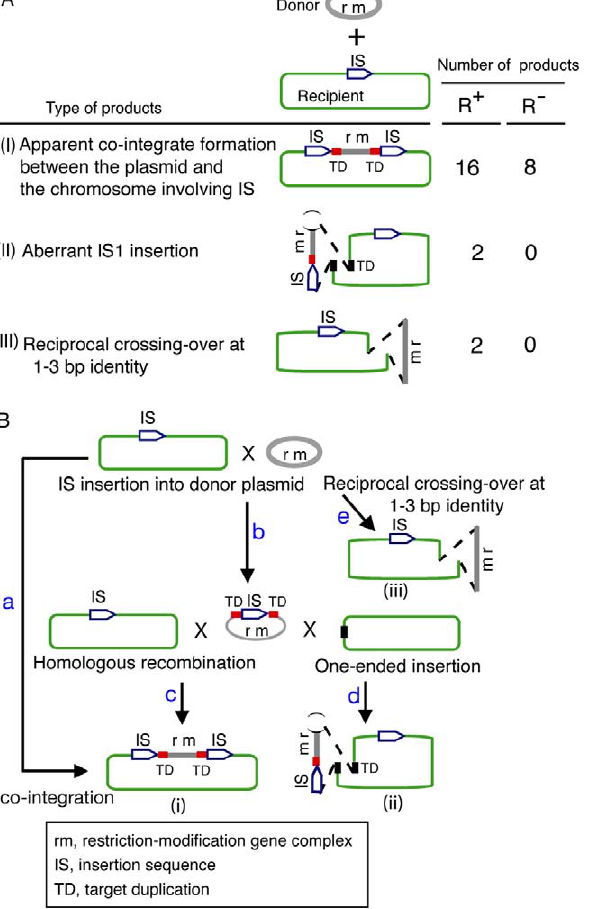
Figure 4. Product structure. A . Three types of transposition products. (I) Apparent co-integrate . Apparent co-integration of the plasmid and the chromosome at IS1 or IS5 already present on the chromosome. IS1 integration was associated with target duplication (TD in red) of 8–10 bp at various donor (plasmid) sites. IS5 generated a 4-bp target duplication at various donor sites (Figures S2and S3). (II) Aberrant IS insertion . De novo insertion of IS1 with the entire plasmid, except for a 1- or 3-bp terminal deletion (black parentheses). The chromosomal locus had a 9-bp target duplication. The right end of the plasmid insert was similar to the end of IS1 in one product (Figure S4). (III) Reciprocal recombination . Reciprocal crossing-over between the plasmid and the chromosome involving 1- or 3-bp region of sequence identity (Figure S5). B. Hypothetical routes to the products. (a) One-step co-integrate formation between the chromosome and the plasmid at a chromo- somal IS. (b) Chromosomal IS insertion into the RM plasmid. (c) Homolo- gous recombination between the plasmid IS and a homologous chromosomal IS leading to the apparent co-integrate. (d) Plasmid IS experiences one-ended transposition into a new chromosomal